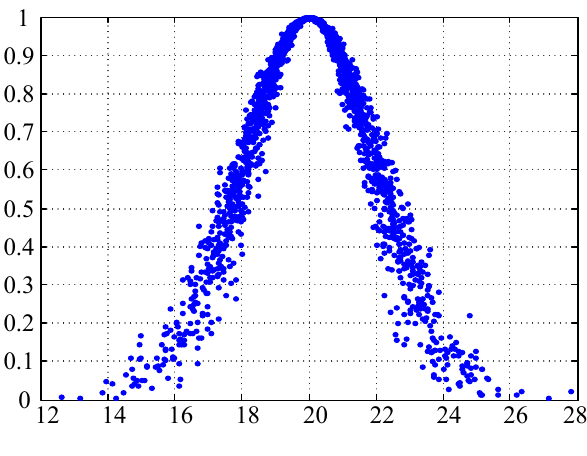
Figure 3. Image of “about 20”